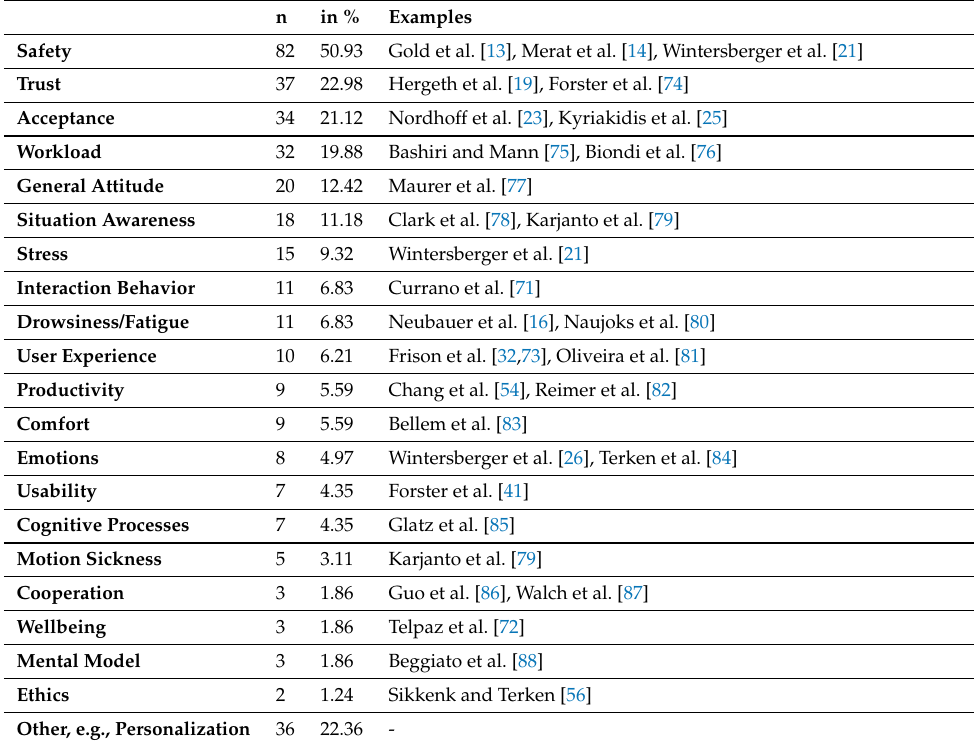
Table 1. Constructs investigated by papers, with a non-exhaustive list of example papers for each